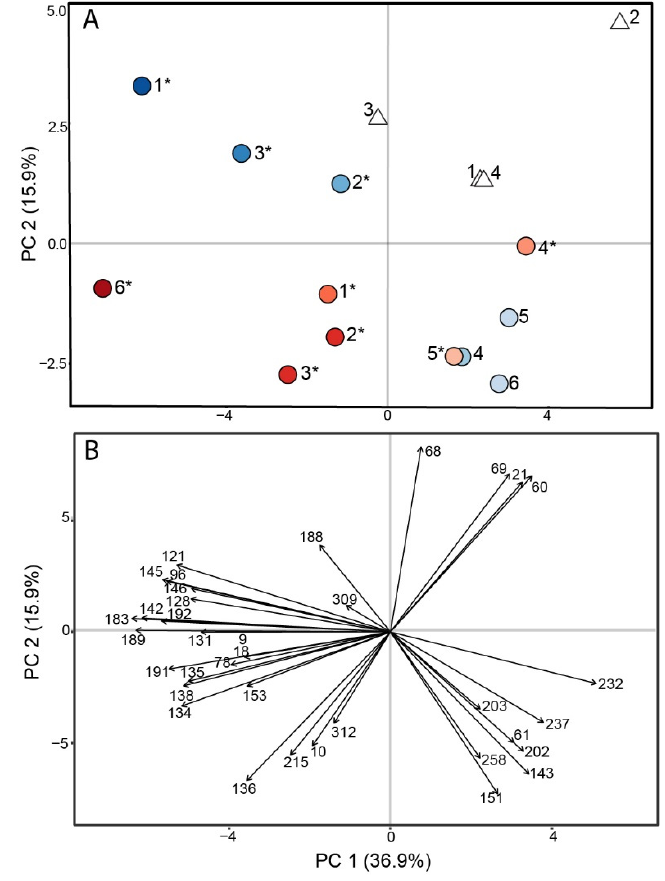
Figure 4. Immune-correlated VOCs recapitulate the clustering patterns produced by BALF cytokines. Principal component analysis score plot ( A ) and loading plot ( B ) using 36 immune-correlated volatile organic compounds (VOCs) from BALF as variables, and mice inoculated with C. immitis RS (blue circles), C. posadasii Silveira (red circles) or PBS (white triangles) as observations. The score plot ( A ) shows the mice separate on PC1 in a pattern that corresponds to their total cytokine production, and mice with moderate-to-high levels of cytokines separate by infection strain on PC2. The color gradient of the markers, darker to lighter, indicates total cytokine abundance, higher to lower; disseminated disease is indicated with an asterisk. The loading plot ( B ) shows the 12 VOCs that are negatively correlated with cytokines load onto PC1 > 0 where the mice with the lowest total cytokines cluster, and the remaining 24 positively-correlated VOCs load onto PC1 < 0 with the mice with moderate-to-high levels of cytokines. Additional information about the VOCs, including putative identities, is provided in Supplementary Table S3.